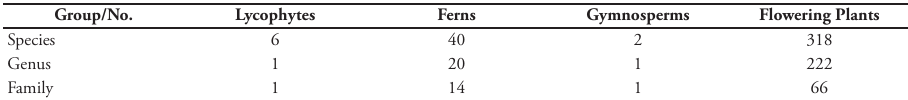
Table 5. Number of plant families, genera and species collected in field surveys in 2016–2020 from Batu